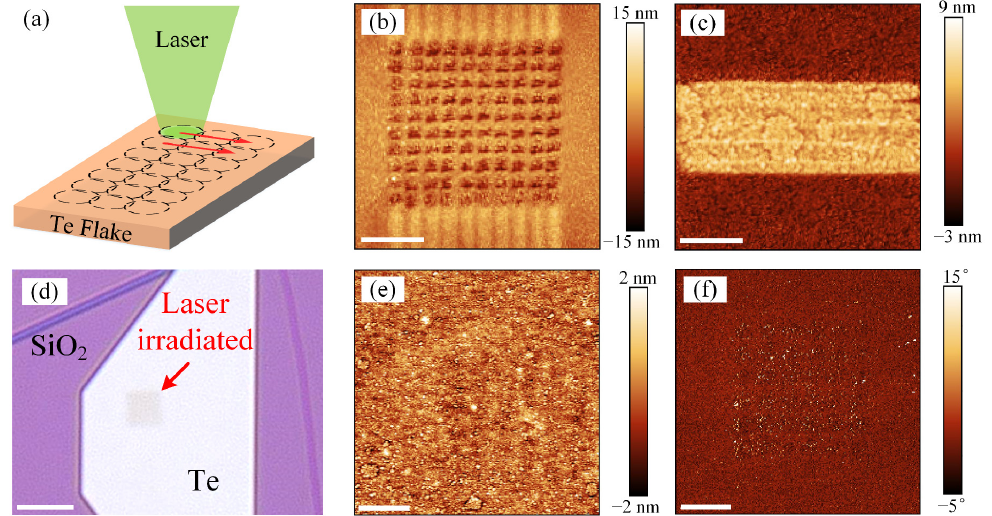
Figure 6. Laser patterning of a Te flake with thickness of 25 nm. ( a ) schematic of the laser pattering process, the dash cycles and red arrows represent the locations and moving directions of laser spots, respectively; laser-induced hole array ( b ) and increase of thickness ( c ) in the Te flake; optical ( d ), AFM height ( e ), and AFM phase ( f ) images of laser-irradiated Te flake without damage of surface, the scale bars in optical images and AFM images are 5 μ m and 1 μ m, respectively;.